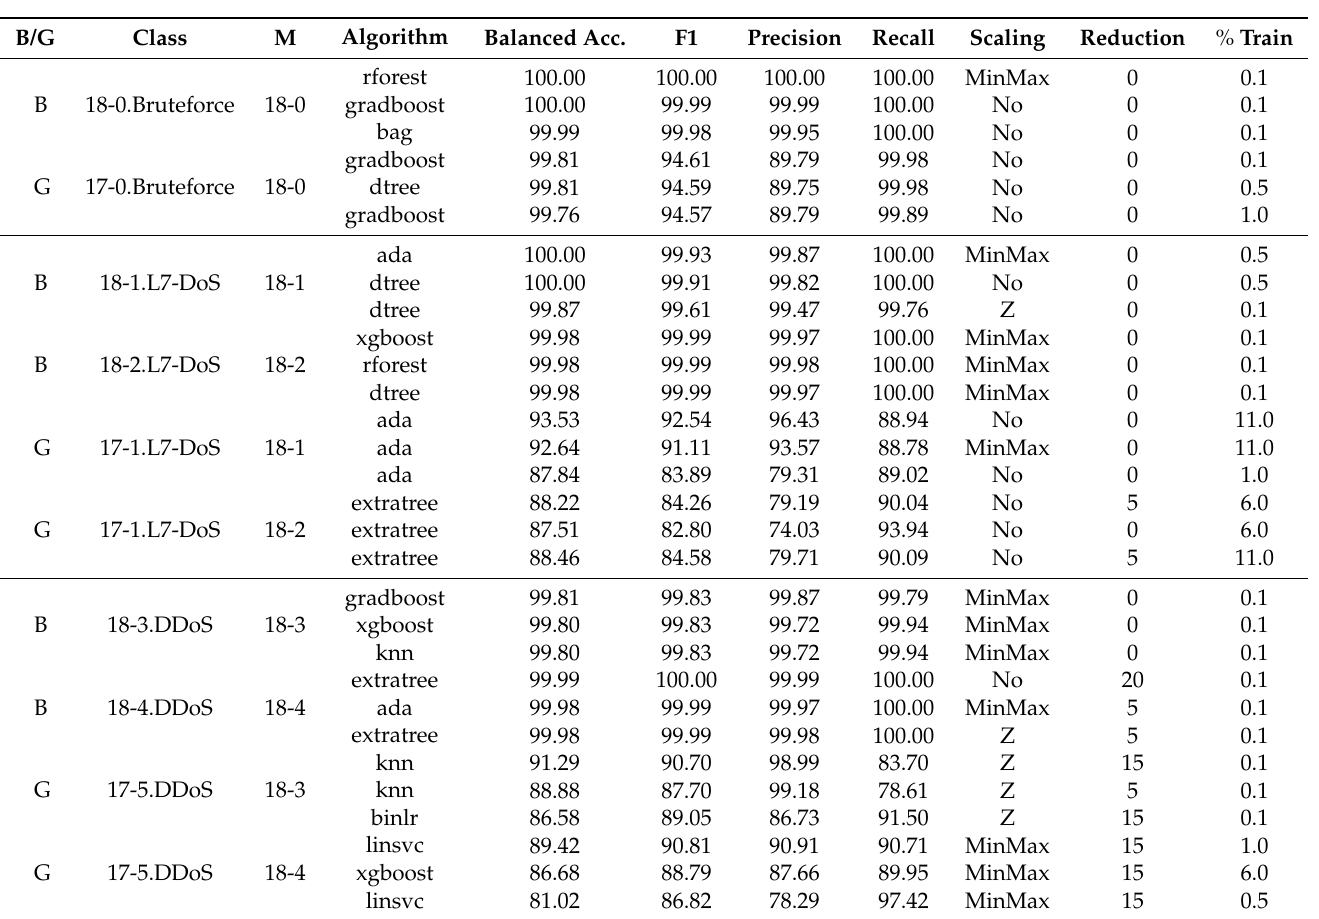
Table 7. Classification metrics for the best 3 models per attack class, both for baseline (B) and generalized (G) classification, with mention of the preprocessing